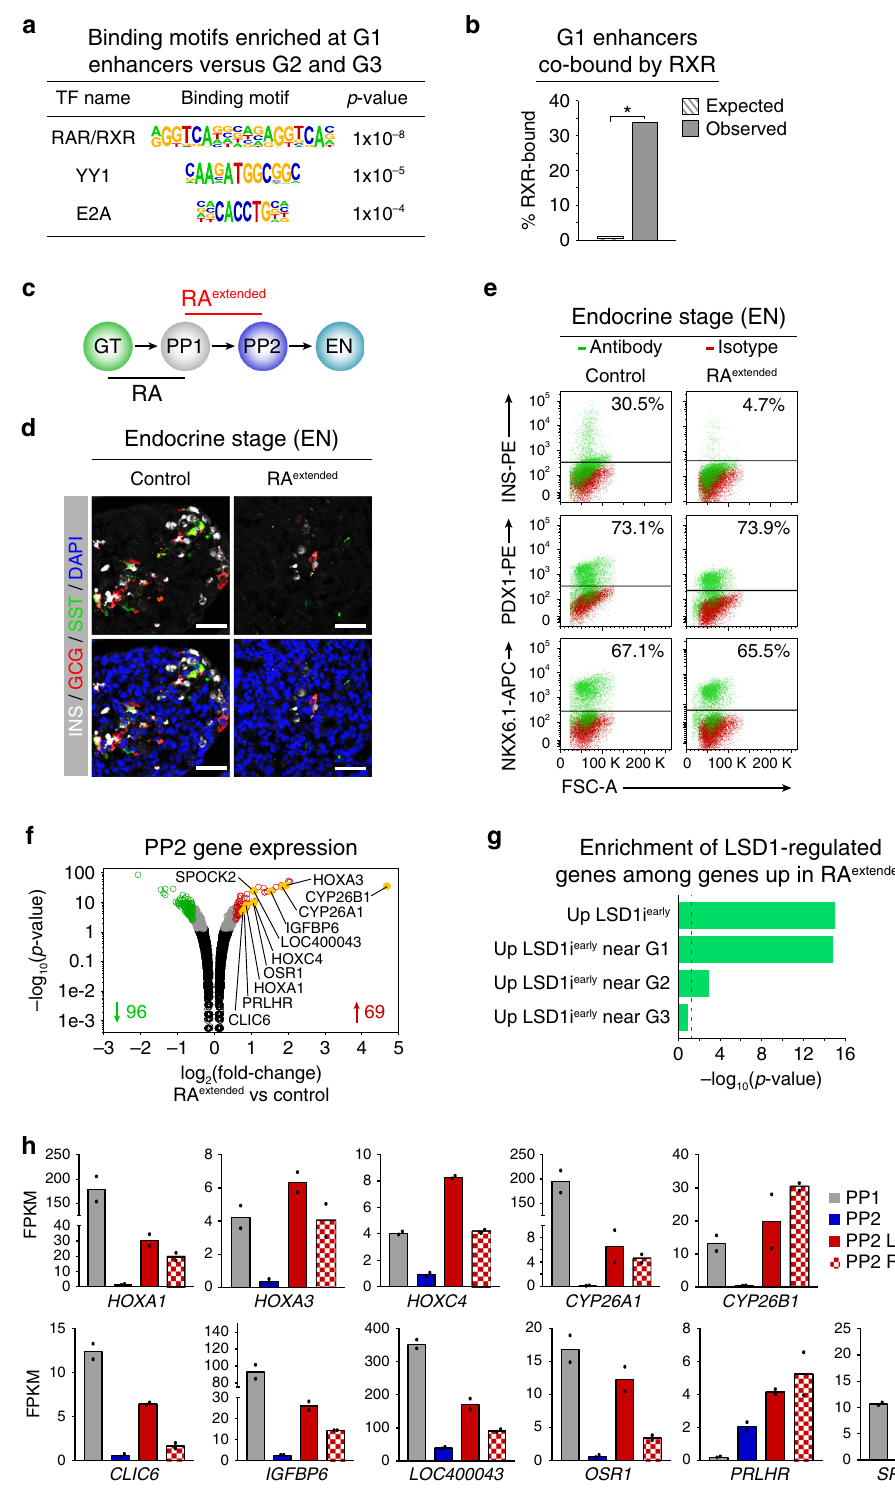
genes were downregulated and 69 upregulated in RA extended PP2 cultures (Fig. 4f and Supplementary Data 18 and 19; p < 0.05, ≥ 1.5-fold change), suggesting that the endocrine differentiation block is mediated by dysregulation of a modest number of genes. Consistent with the small number of dysregulated genes in RA extended cells compared to LSD1i early cells, RA extended cells more closely resembled untreated PP2 cells than LSD1i early cells (Supplementary Fig. 6e). Strikingly, genes upregulated after